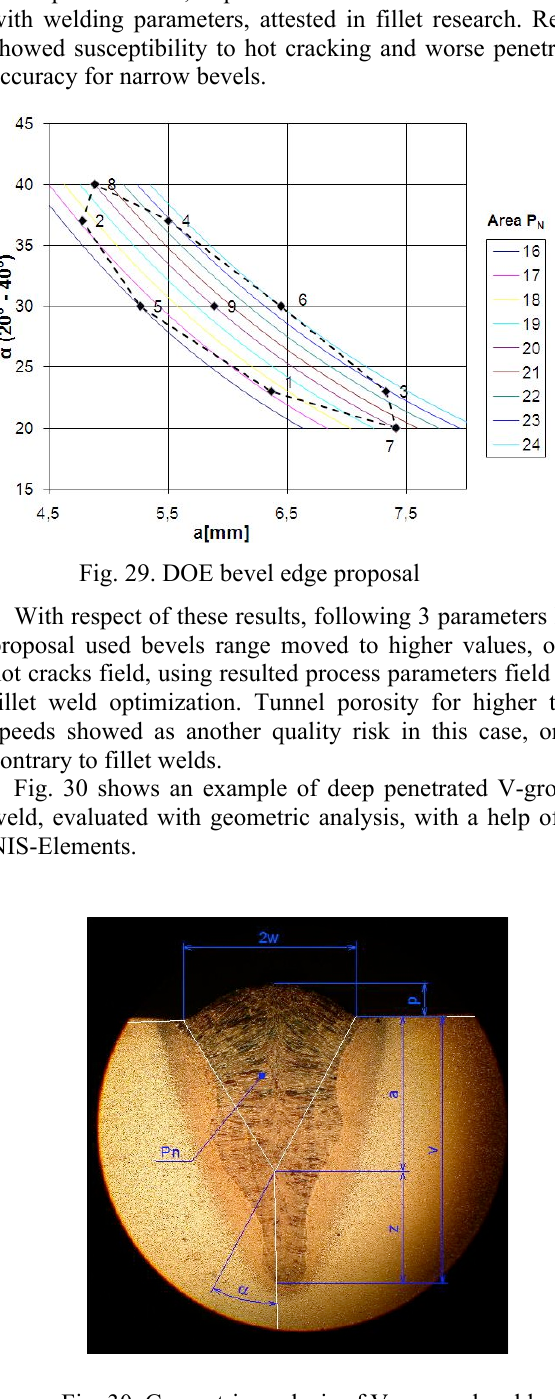
Fig. 30. Geometric analysis of V-grooved